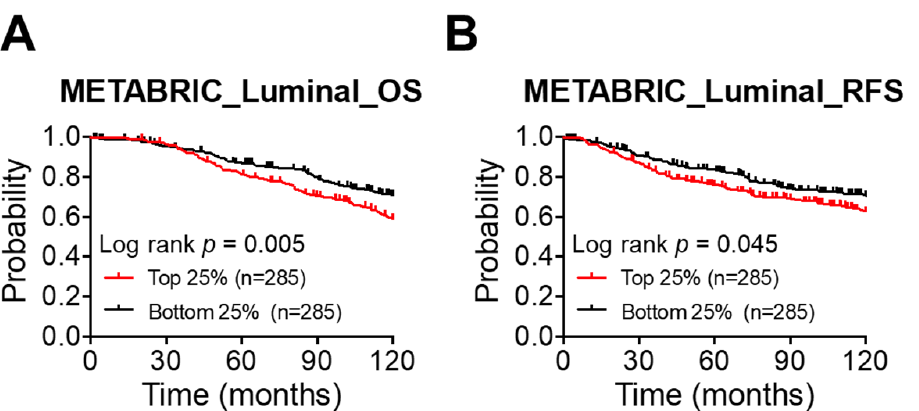
Figure 1. High expression of PKM2 is significantly associated with worse overall survival in luminal tumors. ( A , B ) A 10-year overall survival ( A ) and relapse-free survival ( B ) analysis based on the expression level of PKM2 in luminal tumors. Data were obtained from the METABRIC online dataset. The mRNA expression levels of PKM2 were divided into quartiles. An analysis between the top quartile group (top 25%) and the bottom one (bottom 25%) was then compared by a log-rank